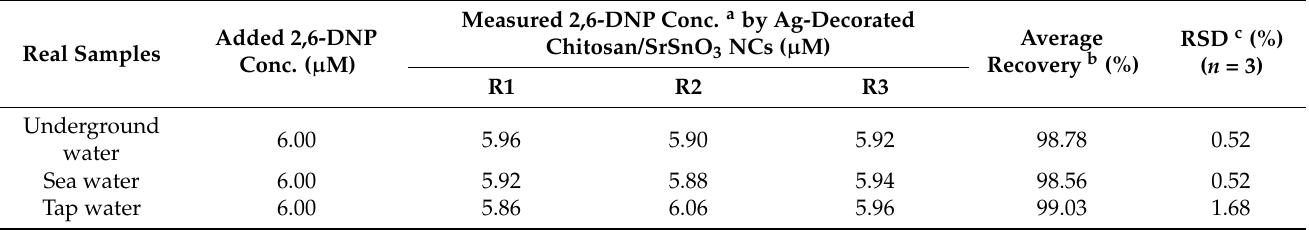
Table 2. Analysis of real samples with Ag-decorated Chitosan/SrSnO 3 NC/PEDOT:PSS/GCE sensor probe by electrochemical approach in room